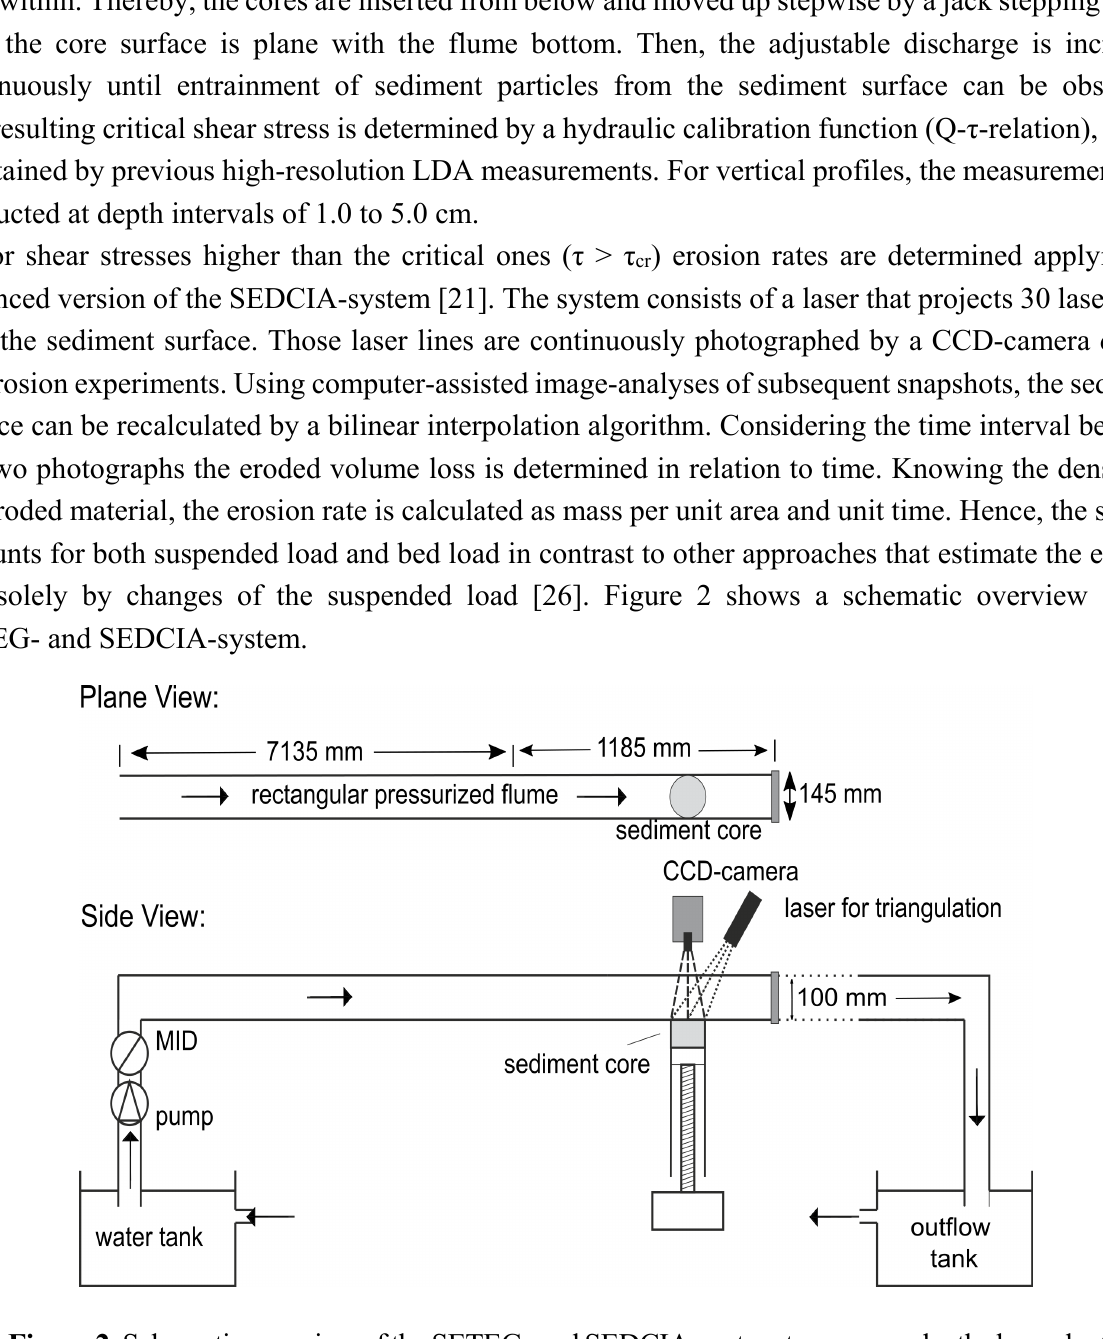
Figure 2. Schematic overview of the SETEG- and SEDCIA-system to measure depth-dependent critical shear stresses and erosion rates in the laboratory